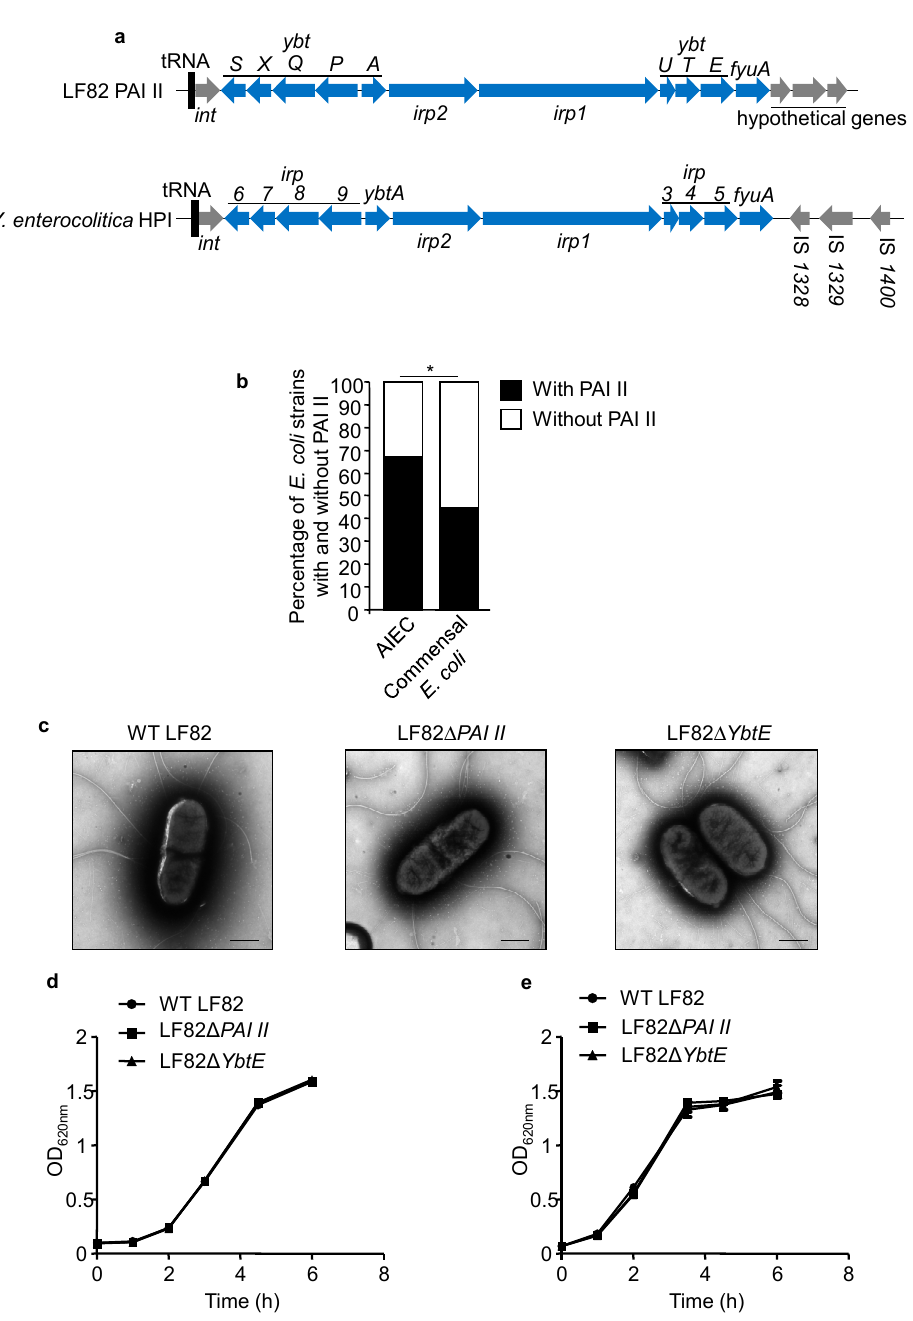
Figure 1. Loss of yersiniabactin does not affect AIEC LF82 morphology and growth in culture media. ( a ) Genetic organization of LF82 pathogenic island (PAI) II showing its similarity to Yersinia enterocolitica HPI. The genes at the same position in these two pathogenicity islands share similar sequences but were given different names. ( b ) Number of adherent-invasive Escherichia coli (AIEC) or commensal E. coli strains with (black bars) and without (white bars) PAI II. ( c ) Transmission electronic microscopy images of negatively stained wild-type (WT) LF82 and mutants LF82 Δ PAI II and LF82 Δ YbtE . Bars = 500 nm. ( d , e ) Bacteria were incubated at 37 °C in LB ( d ) or DMEM/F12 ( e ) medium, and optical density (OD) at 620 nm was measured at the indicated times. Values are means ± SEM of six replicates and are representatives of two independent experiments. * p < 0.05; by chi-square test ( b ).